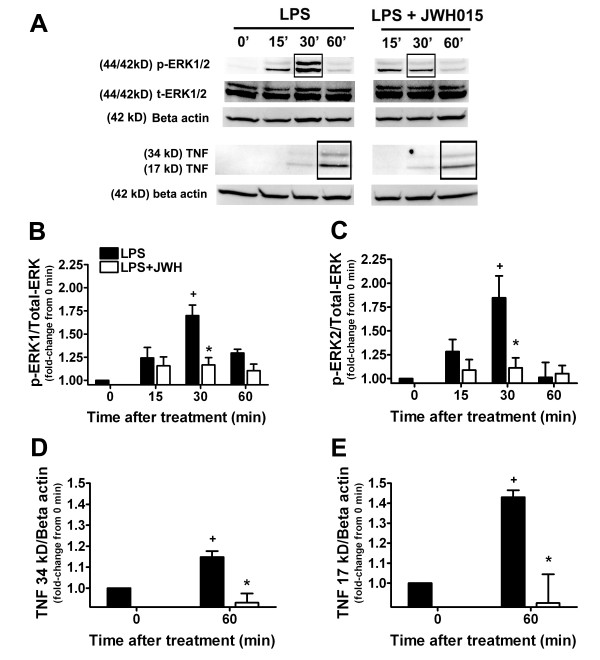
Effects of microglial CBR2 activation on the ERK/TNF pathway. Representative western blots (A) and quantification of p-ERK1 (B), p-ERK2 (C) and TNF (D, 34 kD; E, 17 kD) expression at different incubation time points (15–60 min, 0 = medium control group) in LPS-stimulated microglia in the presence or absence of JWH015 (1 μM). JWH015 produced a ERK dephosphorylation (30 min) and TNF reduction (60 min). +p < 0.05 vs. medium control group; *p < 0.05 vs. LPS alone group.